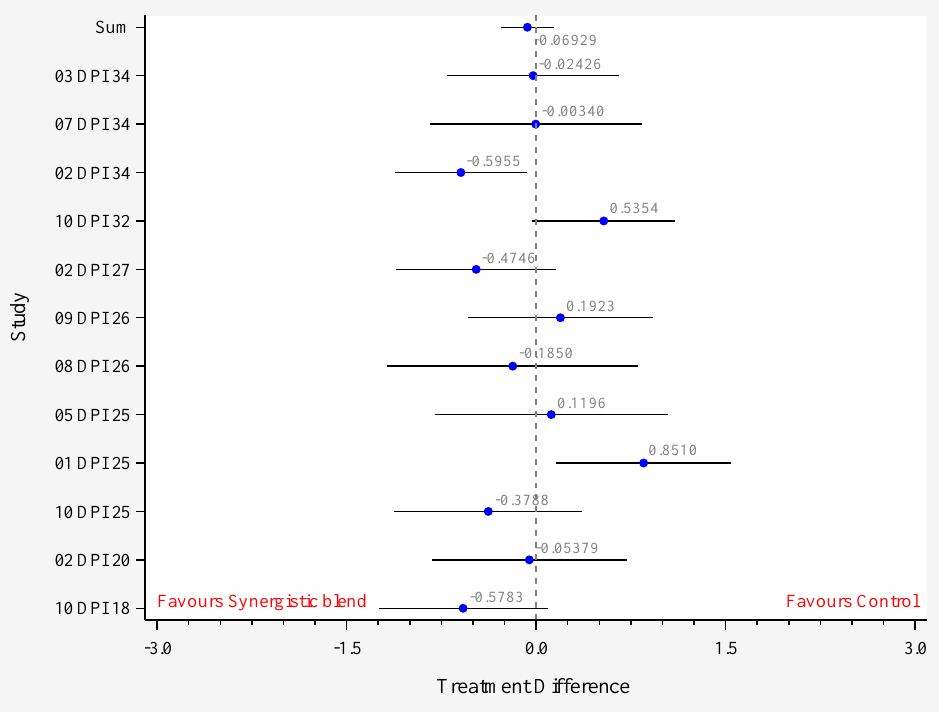
Figure 3. Forest plot showing the difference of the mean between control and synergistic blend (Treatment) for each study, and all studies combined (sum; p = 0.591), between 15–34 days post- inoculation (DPI). The circles represent the log CFU/g difference between treatments, the bars rep- resent the 95% confidence limits and the vertical line at 0 represents the value of no difference be- tween treatments. Legend: XX DPI YY with XX = study number (see Table 1) and YY = days post- inoculation.